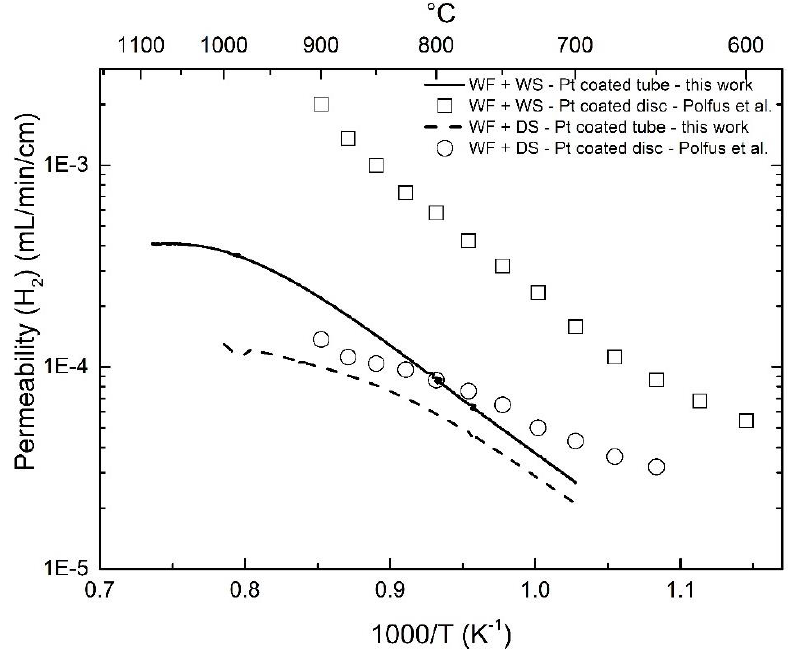
Figure 4. Comparison of hydrogen permeability as a function of temperature for different membrane architectures. The open labels are for disc-shaped membranes coated with Pt at both surfaces [18], and the solid labels for the membrane in this work. The sweep Ar flow is 25 mL/min.